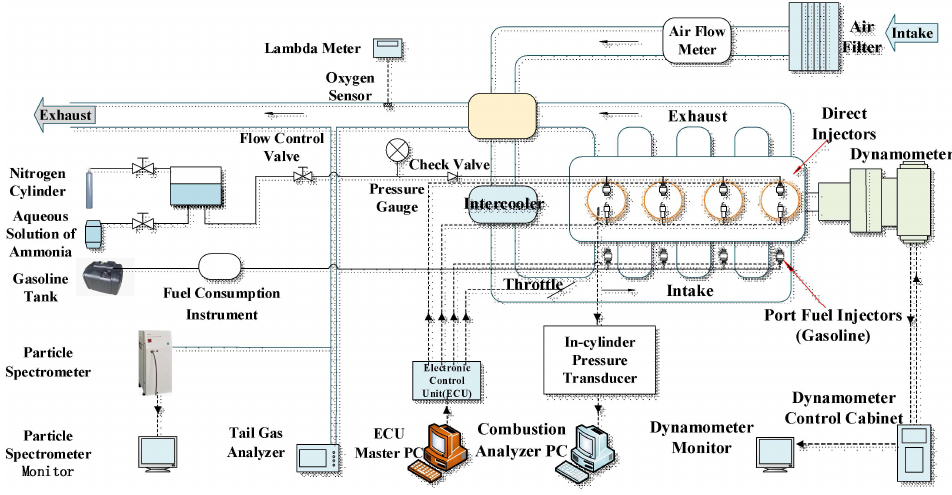
Figure 3. Engine test system.